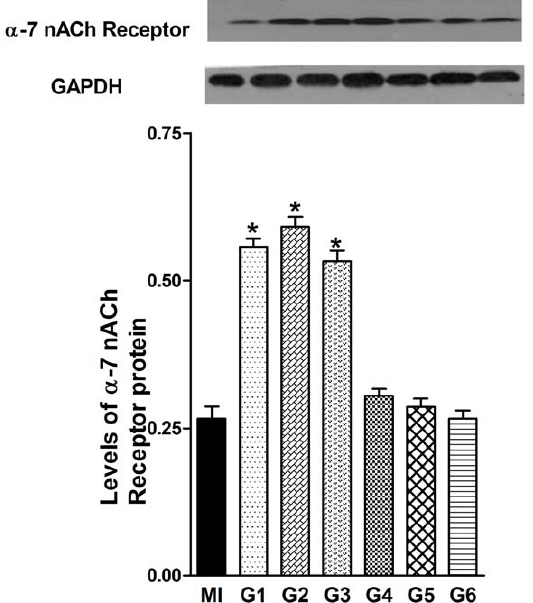
Figure 8. Representative blot and densitometric analyses of a 7- nicotinic receptor protein from the myocardial. The levels of a 7- nicotinic receptor were increased significantly in G1, G2 and G3 compared with the MI group. Data are the mean 6 SEM (n=8). * P , 0.05 compared with MI group.